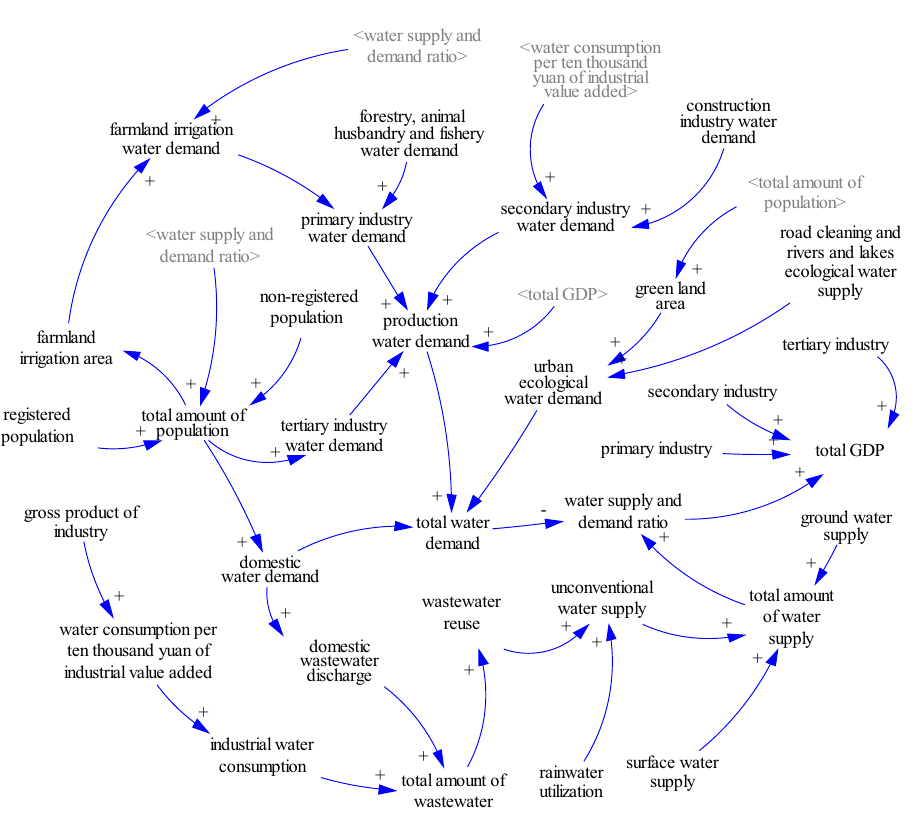
Fig 2. The causal-loop diagram of the Chengdu water cycle